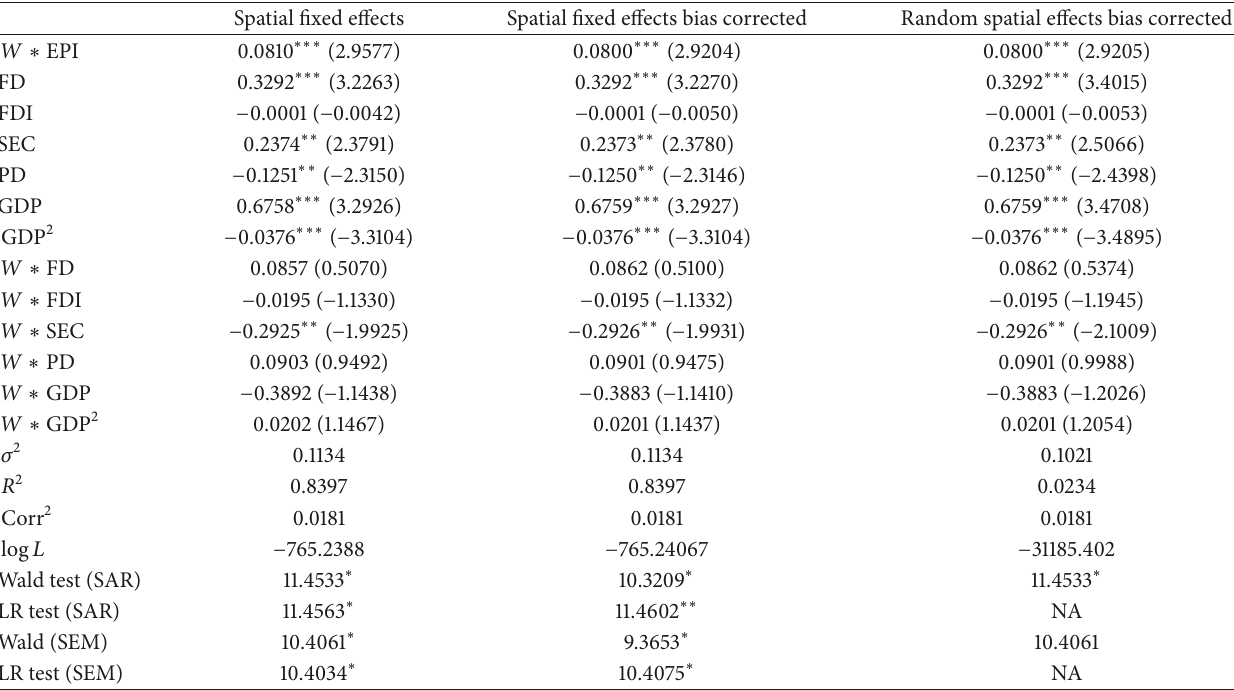
Table 6: Estimation results of spatial Durbin model with spatial specific